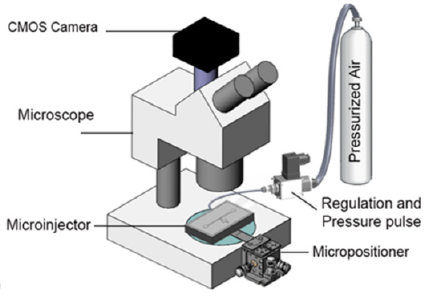
Figure 10. Experimental Setup used for C. elegans microinjection consisted of three major parts: Fluidic system, optical system and microchip.